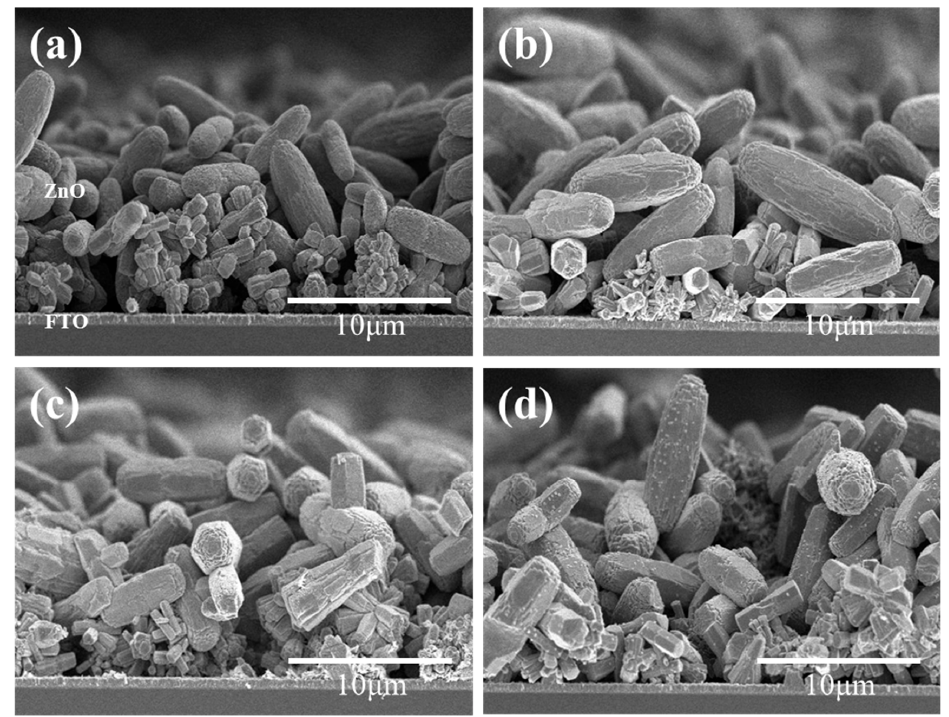
Figure 3. Cross-sectional SEM images of ZnO layer formed on the FTO glass for ( a ) 4 h, ( b ) 6 h, ( c ) 8 h, and ( d ) 10 h growth time.